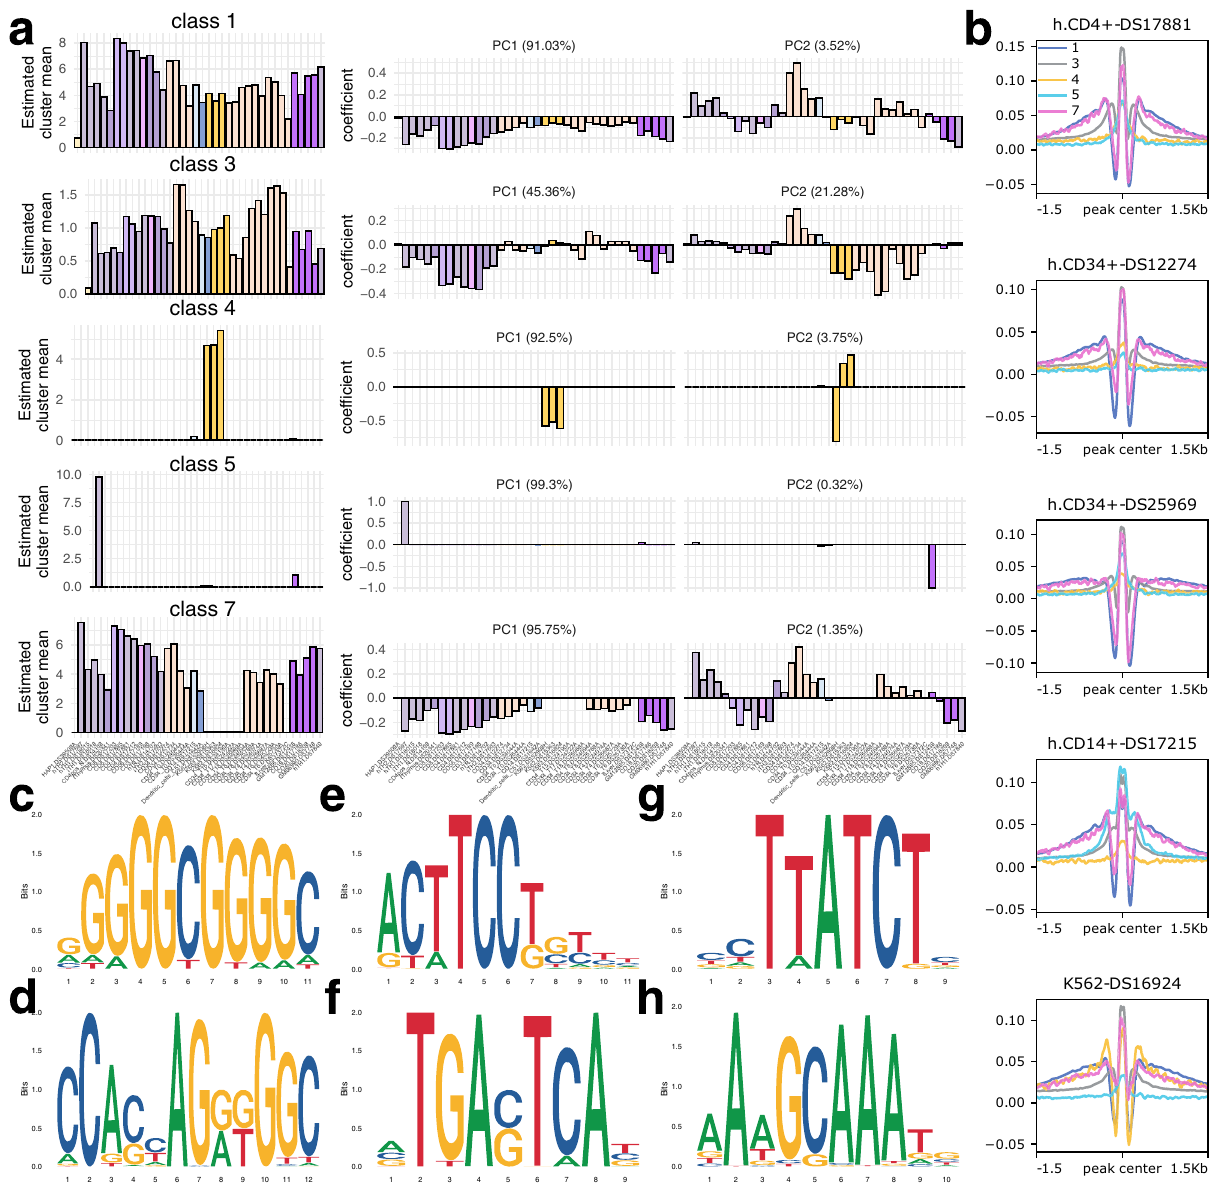
Fig. 5 | CLIMB identi fi es patterns of chromatin accessibility across hemato- poietic cells relating to different transcription factor binding signatures. a CLIMB ’ sestimatedclassmeansacrossall38cellpopulationsareshownalongside the fi rst two sets of eigenvector coef fi cients of the estimated class covariance